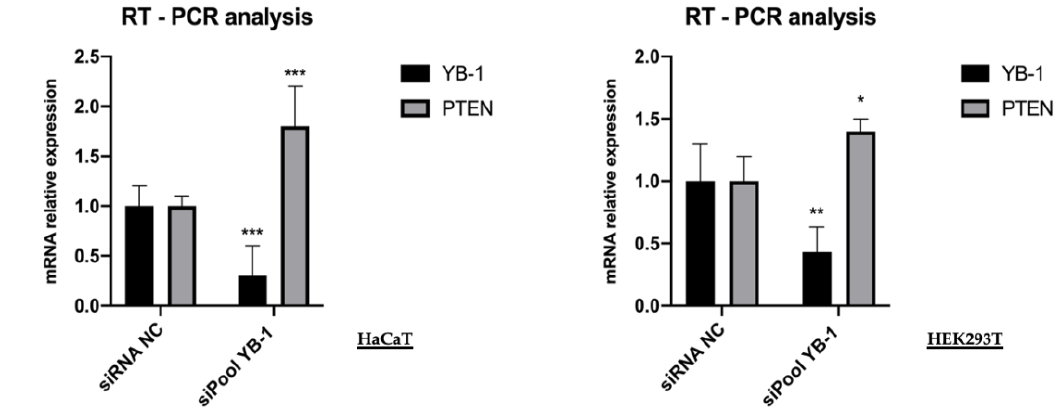
Figure 4. YB-1 depletion increases the level of PTEN transcript. HaCaT and HEK293T cells were transfected with 10 nM final siRNA-poolYB-1 or siNC; the effect on PTEN mRNA level was evaluated 48h post-transfection by qRT-PCR analysis. Relative mRNA levels were plotted on the y-axis and siRNA employed are indicated on the x-axis. RPL0 ribosomal protein mRNA was used for normalization. Statistical analyses were performed using 2-way ANOVA and Sidak’s multiple comparison test. Levels of significance between points of expression are indicated (*** p < 0.001, ** p < 0.01, * p < 0.05).